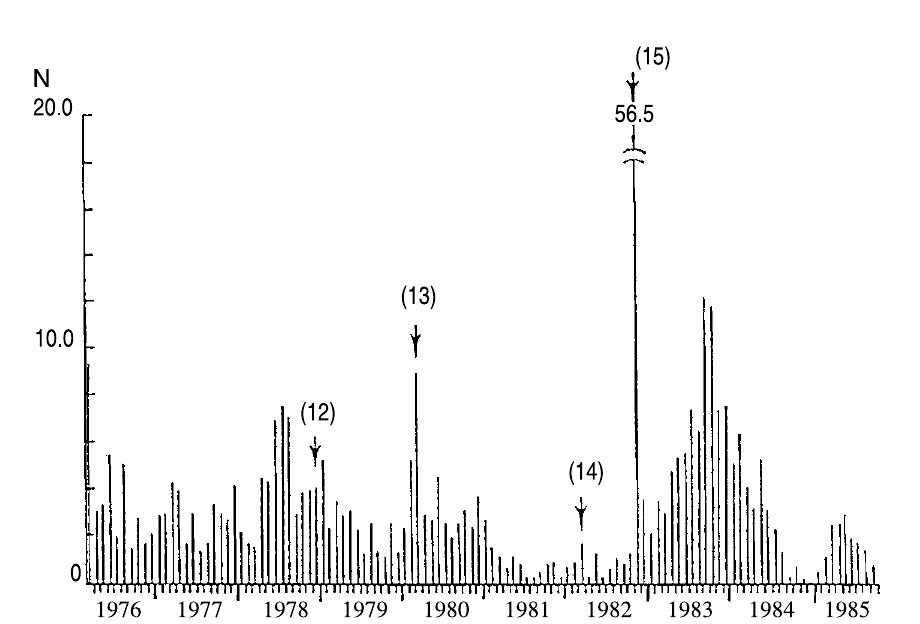
Fig. 9. Monthly mean of daily frequency of volcanic earthquakes at Iwojima, observed for the period 1976~1985 (after Kumagai, 1985). Arrows indicate steam explosions counted since